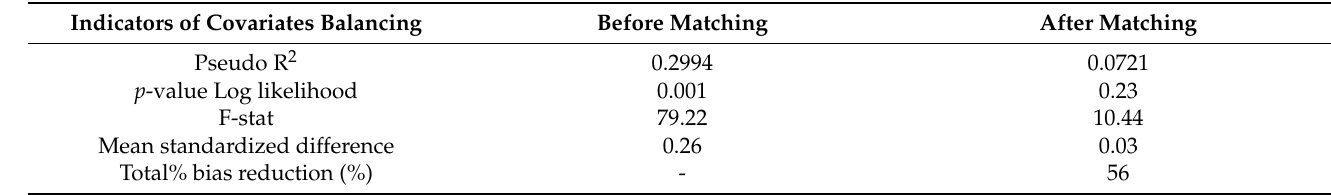
Table 9. Impact of balancing covariates before and after